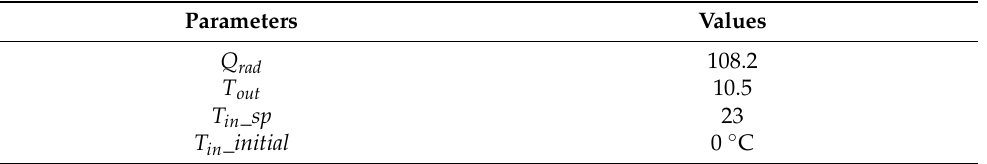
Table 5. Trial and error PI and ON/OFF control